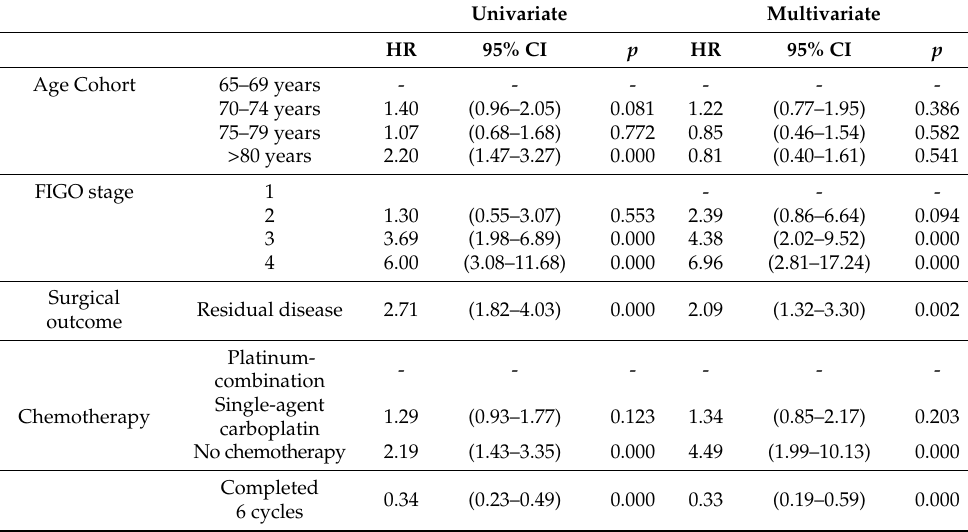
Table 5. Univariate and multivariate factors associated with poorer overall